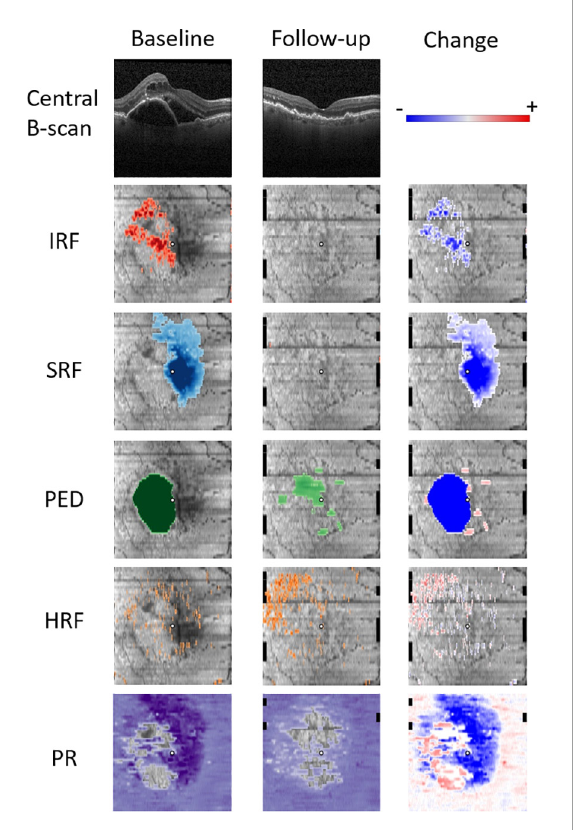
FIGURE1 Quantitative OCT biomarker thickness maps: intraretinal fluid (IRF) in red, subretinal fluid (SRF) in blue, pigment epithelium detachment (PED) in green, hyperreflective foci (HRF) in orange, and photoreceptor (PR) layer thickness in purple. Follow-up scan was acquired 4 weeks after the initial treatment. Change refers to the difference between the baseline and the first